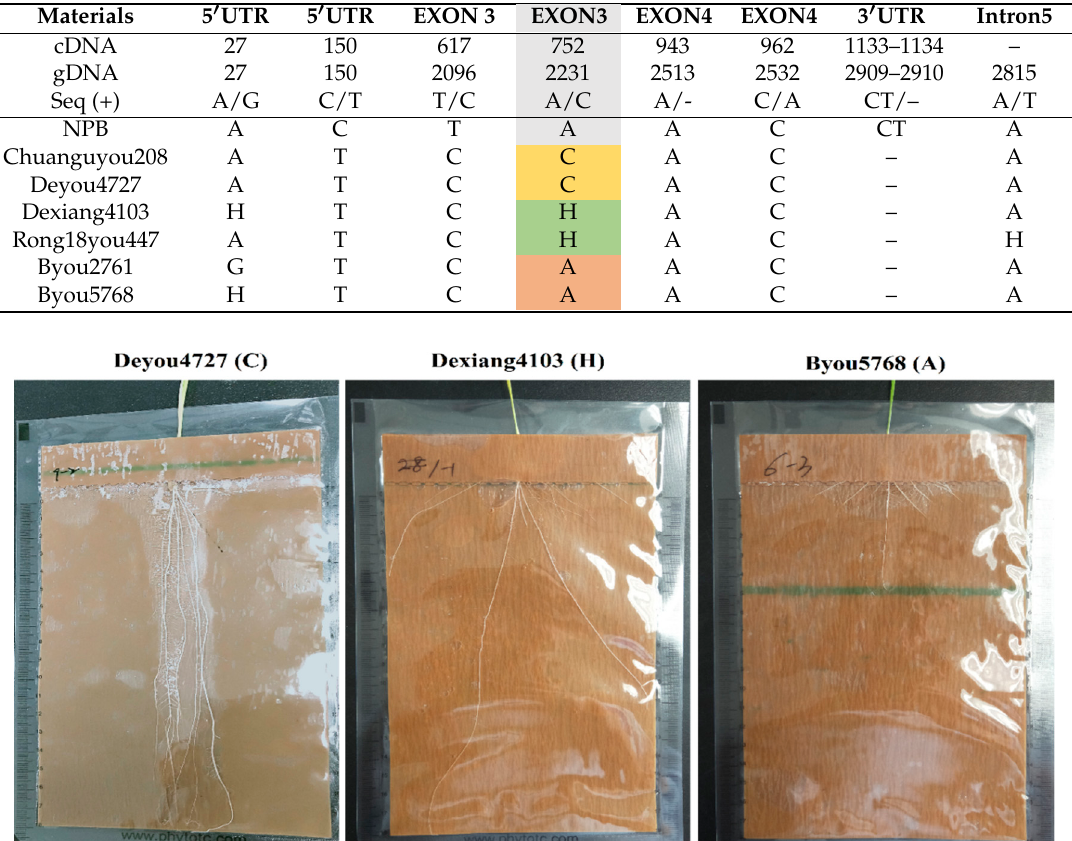
Figure 3. Variation in root length among different group varieties: Deyou4727 (C), Dexiang4103 (H), and Byou5768 (A).